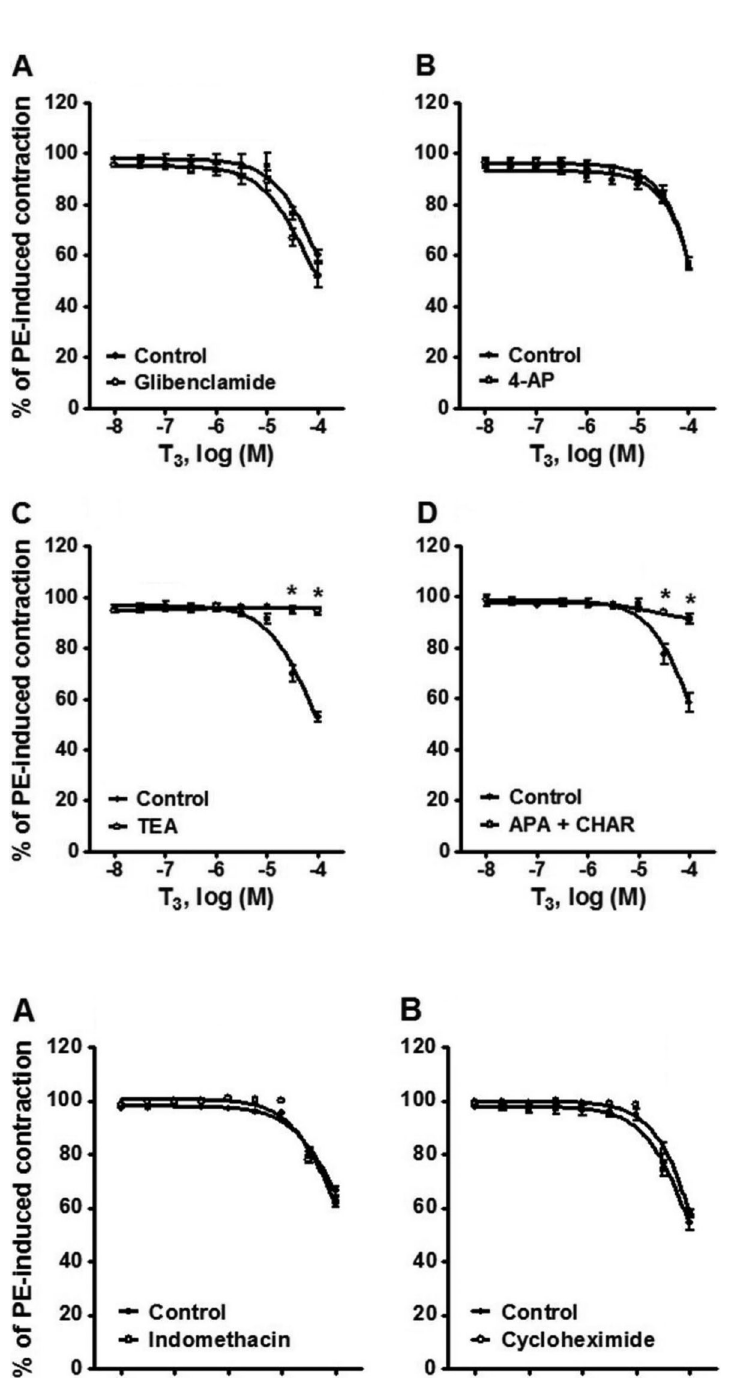
(a direct inhibitor of NOS) (19), 10 -7 M ODQ (an inhibitor of nitric oxide-sensitive guanylyl cyclase) (20), and 10 -6 M KT